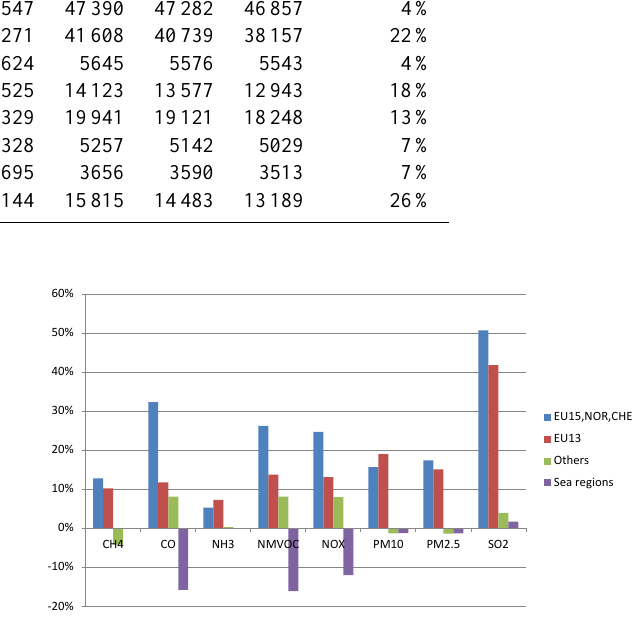
Figure 3. Relative reduction in emissions per country group in 2009 compared to